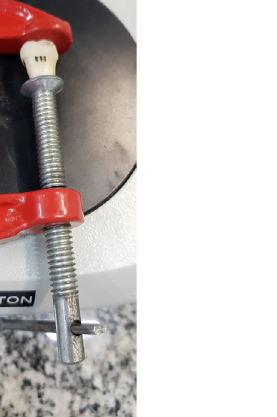
Figure 2. Crown adapted to the prepared dental unit (see vertical reference lines) with the aid of a “C” clamp.